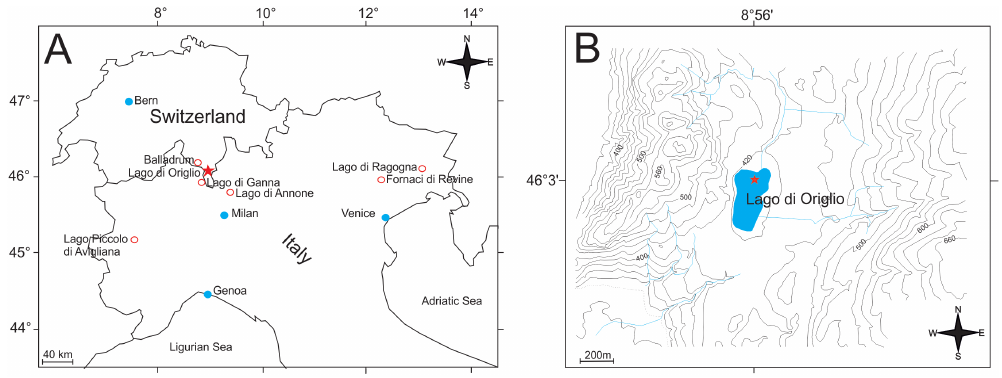
Fig. 1. Map showing the location of the study site. (A) Location of Lago di Origlio within Switzerland (star) and other lowland sites with early afforestation in southern Switzerland and northern Italy (red circles): Lago di Annone (Wick, 1996), Balladrum (Hofstetter et al., 2006), Fornaci di Revine (Friedrich et al., 1999), Lago di Ganna (Schneider and Tobolski, 1985), Lago Piccolo di Avigliana (Finsinger et al., 2006), and Lago di Ragogna (Wick, 2004); (B) Detailed map of the lake, the star indicates the exact location of the